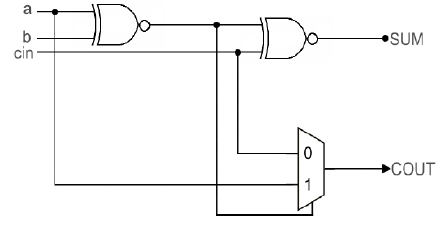
Figure 4. Gate level implementation of a full adder [19].